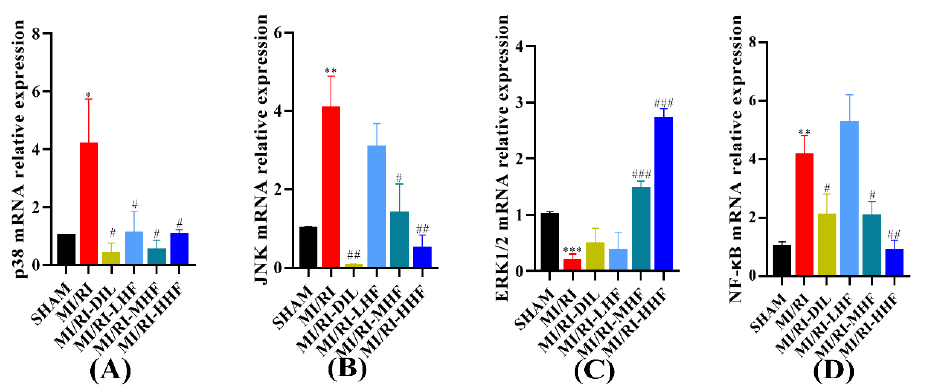
Figure 8. Effect of HF on MAPK/NF- κB mRNA expression. ( A ) p38 mRNA relative expression. ( B ) JNK mRNA relative expression. ( C ) ERK1/2 mRNA relative expression. ( D ) NF- κB mRNA relative expression. * p < 0.05, ** p < 0.01, *** p < 0.001 vs. SHAM group. # p < 0.05, ## p < 0.01, ### p < 0.001 vs. MI/RI group. ( n = 3).